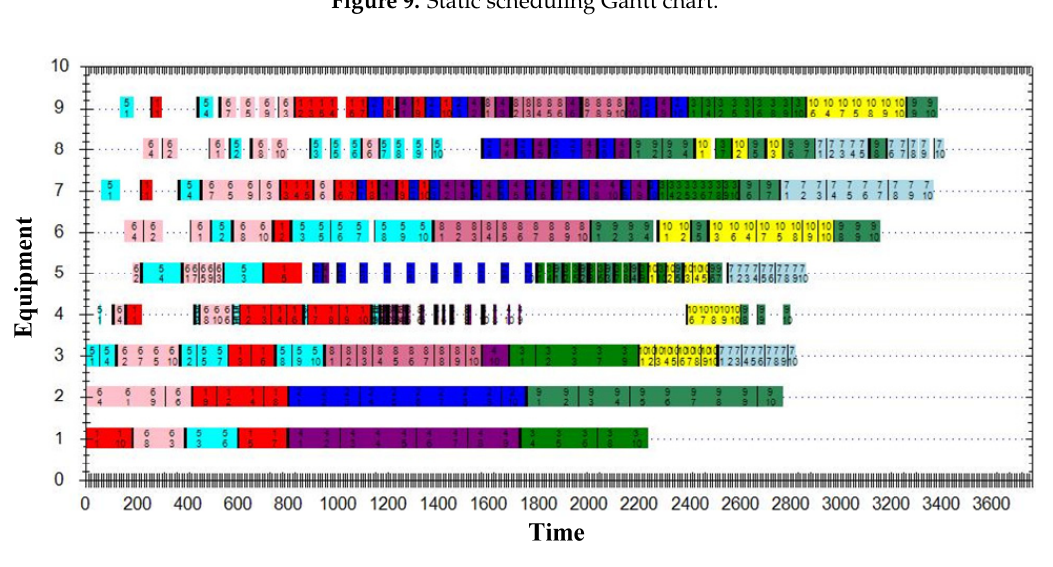
Figure 10. IACO (Improved Ant Colony Algorithm) dynamic scheduling Gantt chart. Appl. Sci. 2017 , 7 , 23